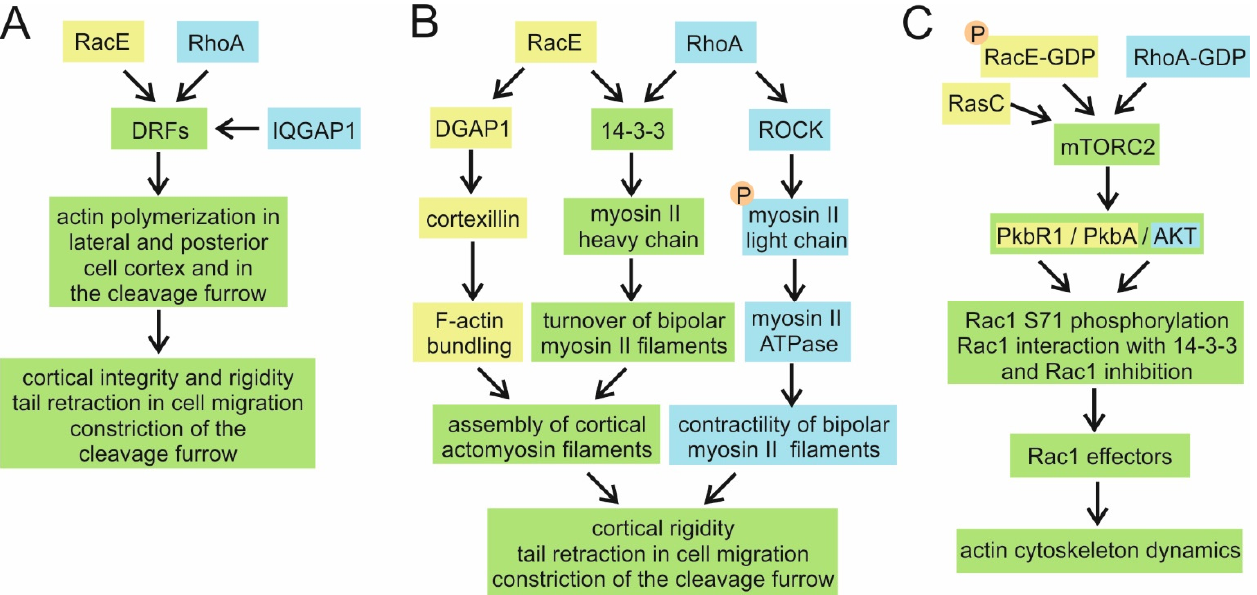
Figure 3. Parallel presentation of major signalling pathways starting from RacE in Dictyostelium ( yellow ) and RhoA in mammals ( blue ) and converging onto the actin cytoskeleton regulation. ( A ) Activation of the DRF-mediated actin polymerization. ( B ) Assembly of the actomyosin filaments and activation of their contractility. ( C ) Activation of the mTORC2—AKT signalling pathway. The common elements shared by Dictyostelium and mammals are shown in green . The default active state of small GTPases is GTP-loaded, except when shown otherwise. Red encircled “P” indicates phosphorylated proteins.